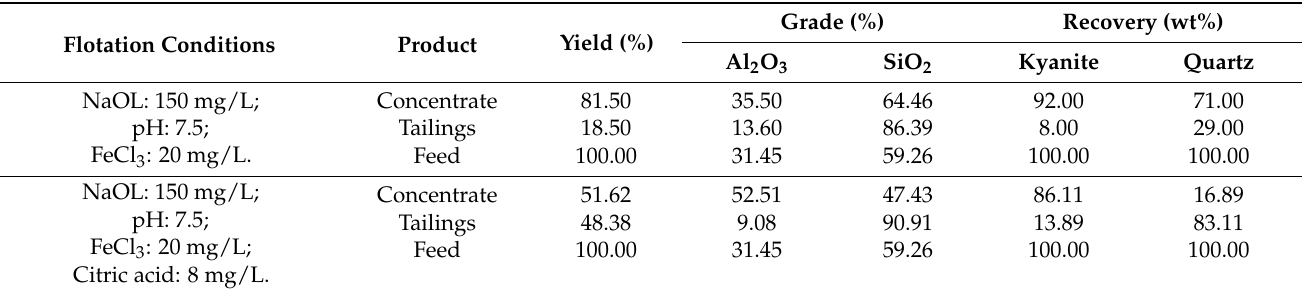
Table 2. Mixed-mineral flotation test results.